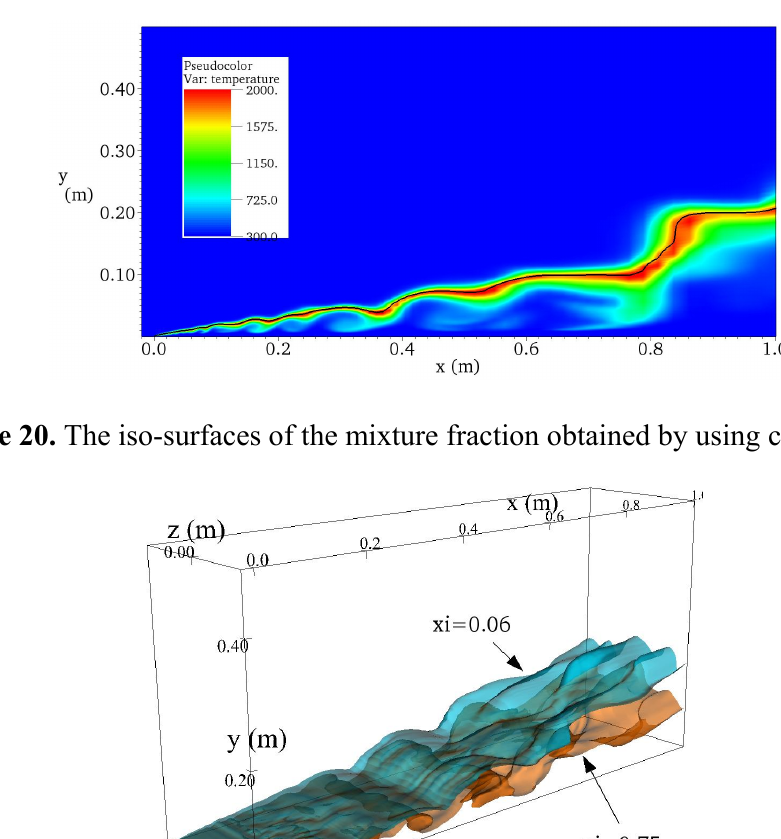
Figure 19. The instantaneous temperature contours in the cross section at z = 0 m, t = 0.536 s obtained by using coarser grid.